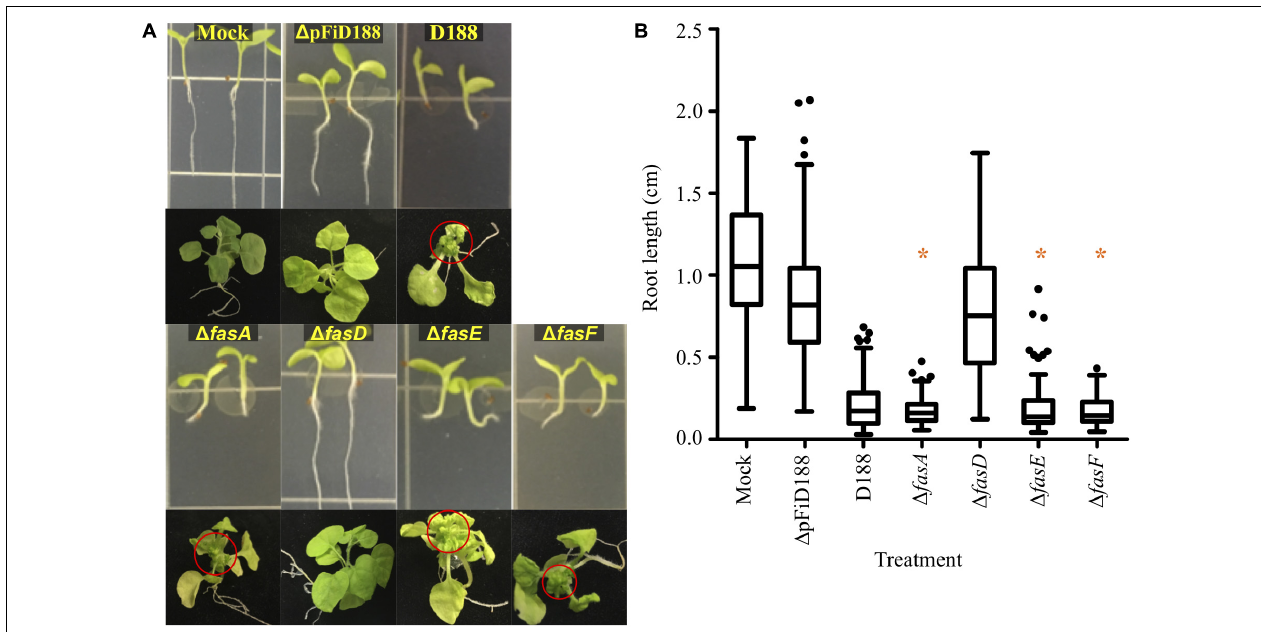
FIGURE 1 | Most fas deletion mutants are pathogenic. (A) Wild type and deletion mutants of Rhodococcus strain D188 were inoculated onto seedlings or meristems of N. benthamiana. Red circles circumscribe leafy galls. This is a composite figure in which photographs were taken of plants treated in different experiments. Images of representative plants are shown. In all experiments, positive and negative control treatments were included. (B) At 7 dpi, roots were imaged and measured. Differences were compared relative to the corresponding D188 control group (* is not significant with a p -value threshold ≤ 0.05). Similar results were reproduced in at least two additional repeats of the